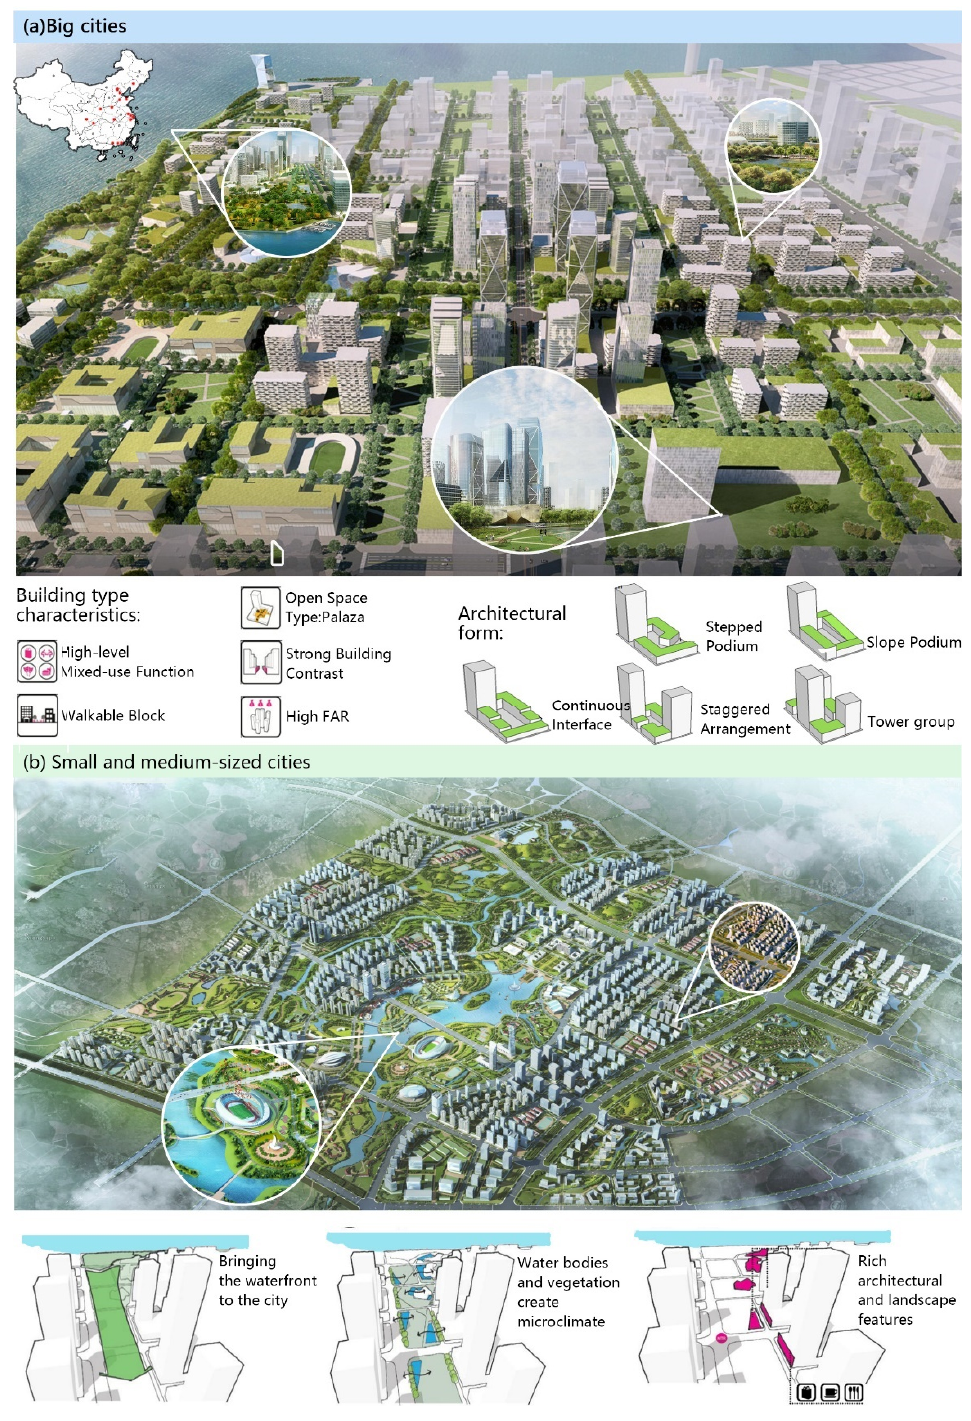
Figure 8. Land use and landscape planning implications for ( a ) big cities and ( b ) small and medium–sized cities.